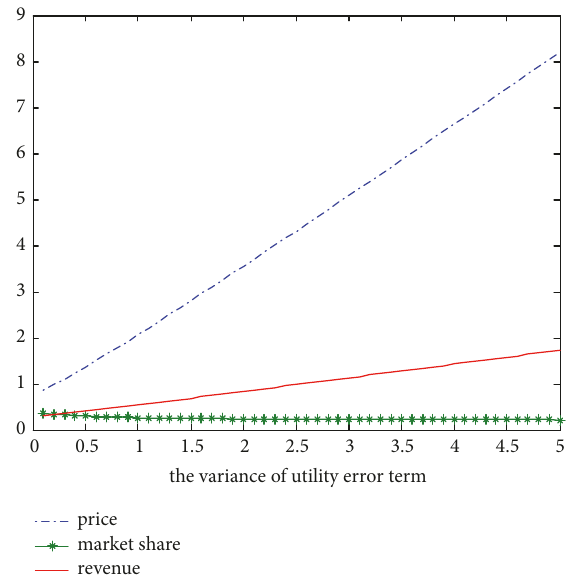
Figure 4: The variation of the optimal solutions with the variance of utility error